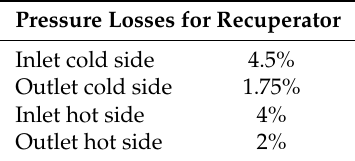
Table 2. Assumptions for recuperator pressure losses from